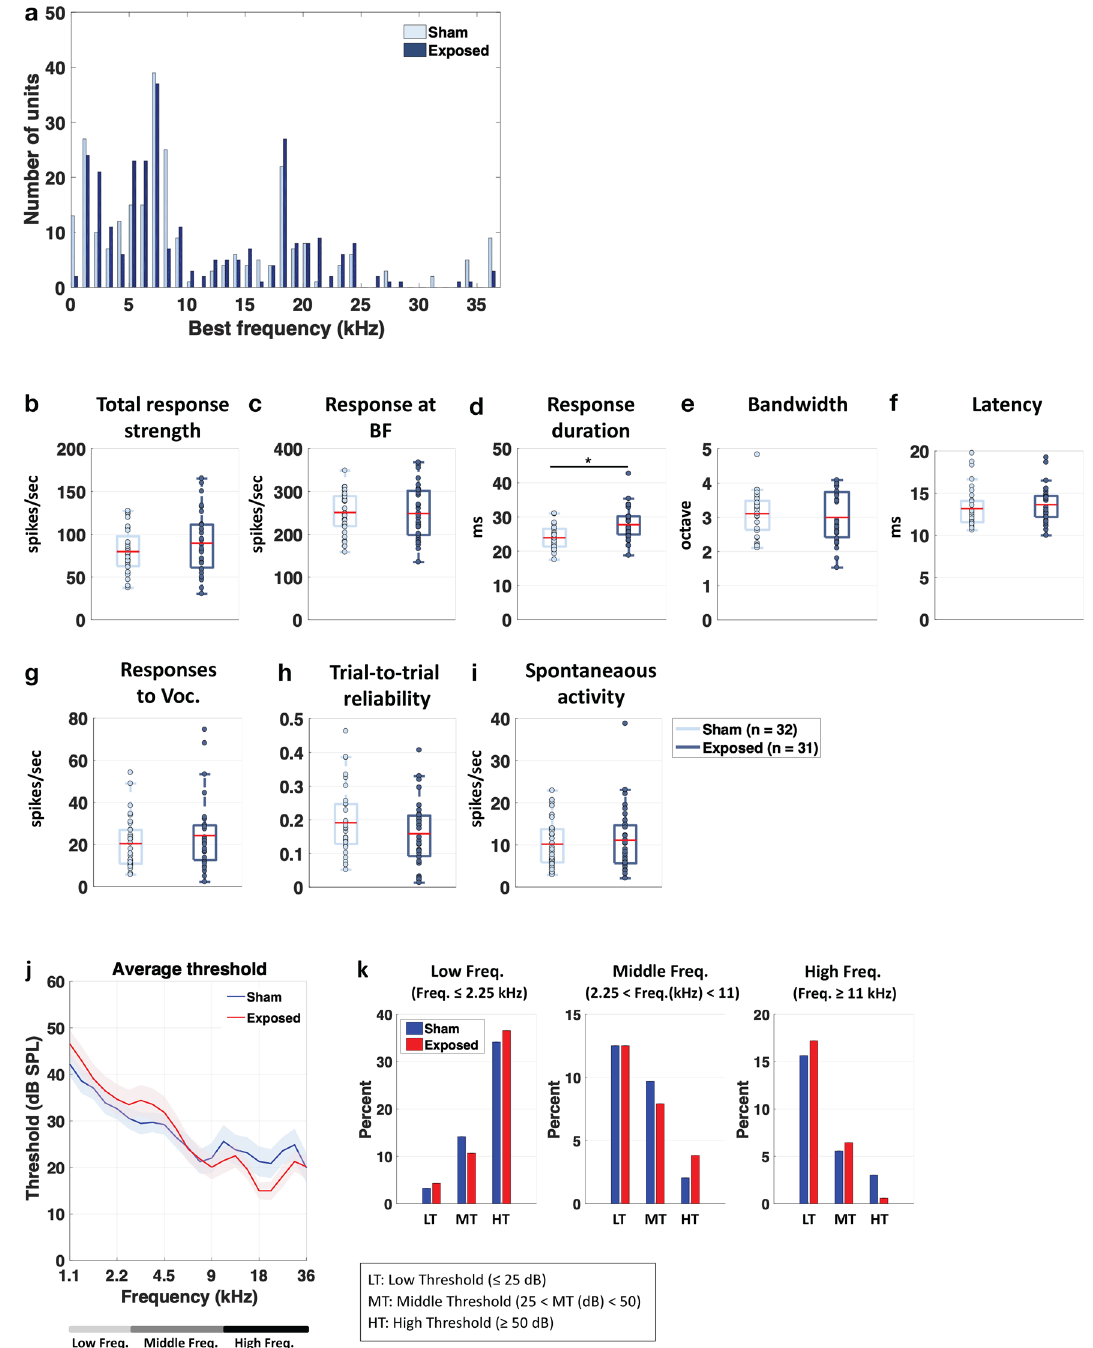
Figure 5. Effects of LTE exposure on parameters quantified from cortical responses in healthy animals. ( a ) BF distributions of the cortical neurons for healthy animals exposed to LTE (in dark blue) and Sham-exposed to LTE (in light blue). The two distributions did not differ. ( b – f ) Effects of LTE exposure on the parameters quantifying the spectro-temporal receptive fields (STRF). The response strength was not significantly changed both on the entire STRF and at the best frequency ( b , c ). The response duration was slightly increased ( d ) but, the response bandwidth and the bandwidth were unchanged ( e , f ). Both the strength and the temporal reliability of the responses to vocalizations were unchanged ( g , h ). Spontaneous activity was not significantly changed ( i ). (*p < 0.05 unpaired t-tests). ( j , k ) Effects of LTE exposure on the cortical thresholds. On average, the threshold were not significantly changed in LTE-exposed rats compared to Sham-exposed rats, but the exposed animals had slightly lower thresholds in the high